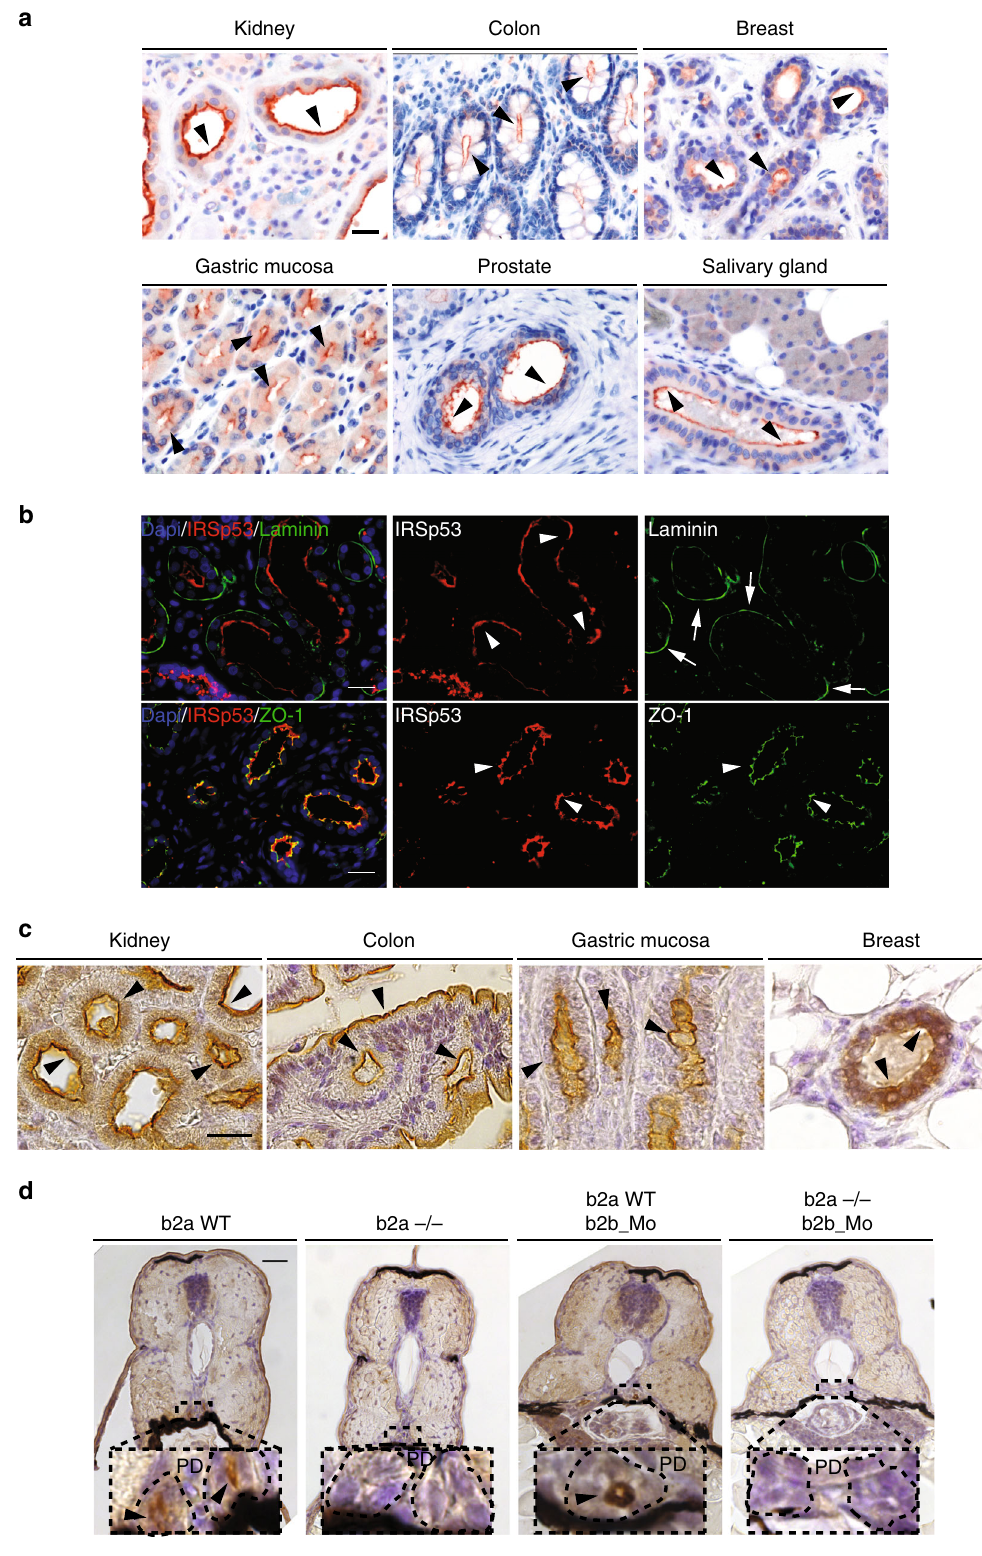
(Fig. 2a, and Supplementary Fig. 2A), partially localized with PODXL and actin in vesicle-like structures (Fig. 4a). These structures were also positive for RAB7, RAB11a, and RAB35 (Fig. 4a), but not for the early and late endosome markers “ early endosome and “